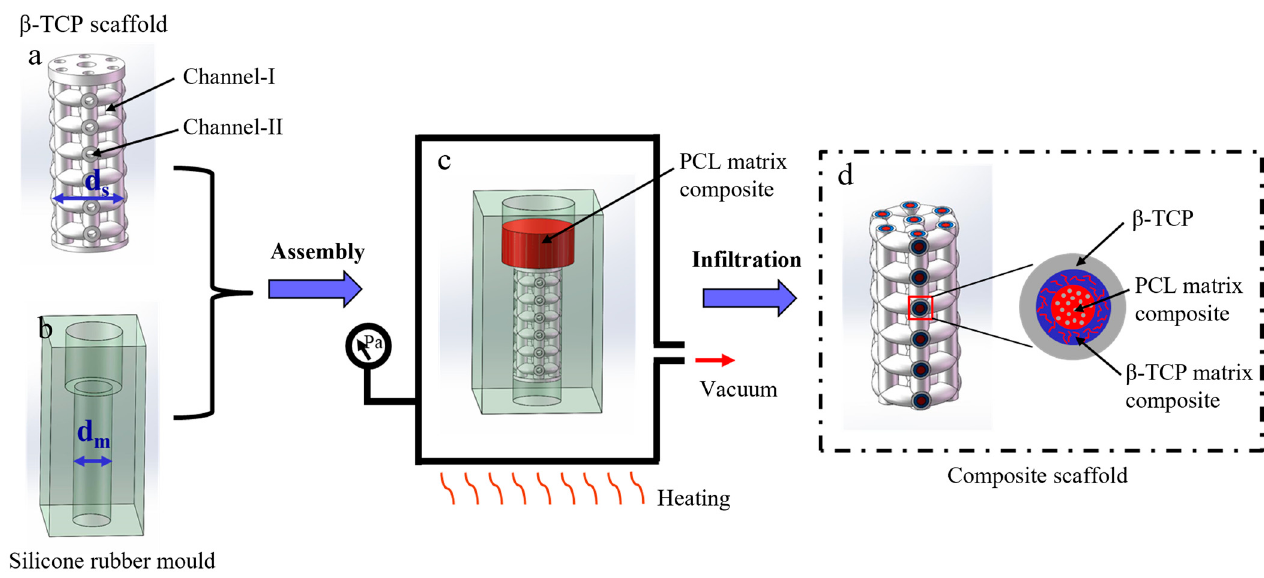
Figure 1. Schematic illustrations of ceramic/polymer composite scaffolds with gradient struc- ture: ( a ) ceramic scaffolds fabricated by DLP, ( b ) silicon rubber mold fabricated by mold method, ( c ) followed by PCL-impregnation of the sintered ceramic scaffolds, ( d ) ceramic/polymer composite scaffolds by cutting off both